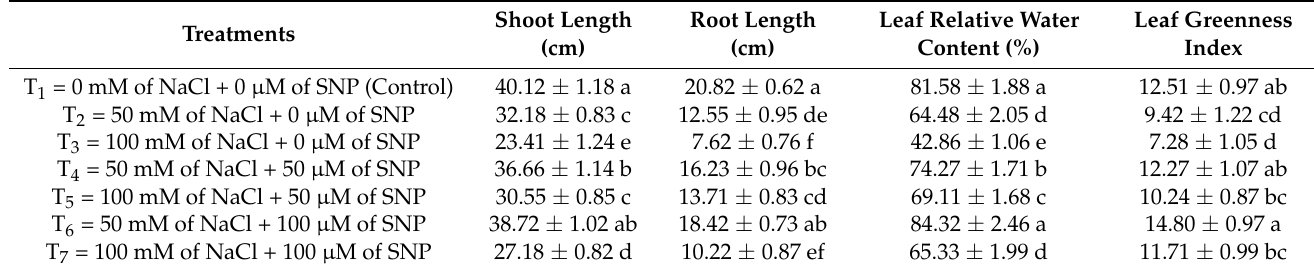
Table 1. Effect of SNP on shoot, root, and leaf attributes of lentils grown under different NaCl levels. Treatments